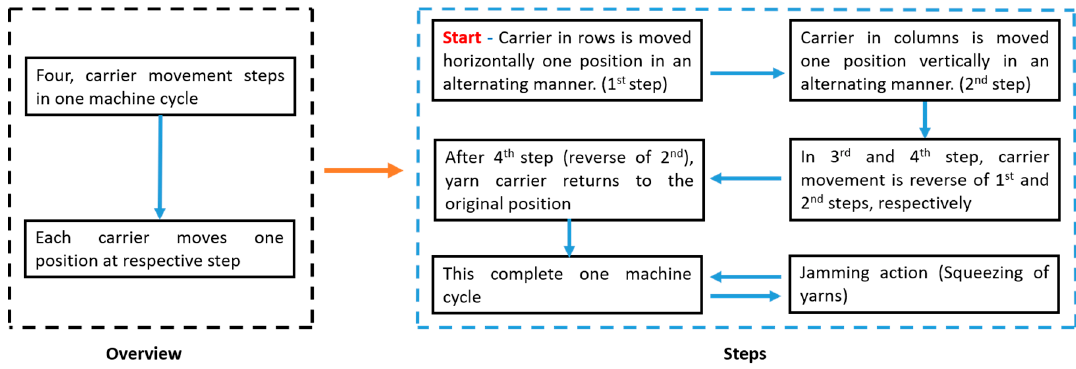
Figure 2. Steps to generate a 1*1 rectangular pattern.